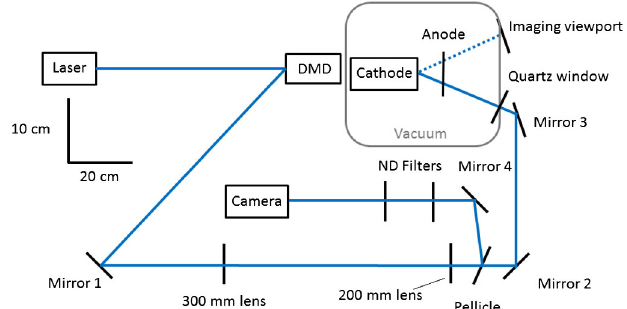
FIG. 2. A schematic of the experimental setup. The DMD selectively reflects a small cross section of the incident laser beam through the rest of the optical components to the cathode. The camera and cathode are the same distance from the pellicle, which allows us to deliver 96% of the laser beam’s power to the cathode and image 4% with the camera. The scale is for the placement, not the size, of optical elements.